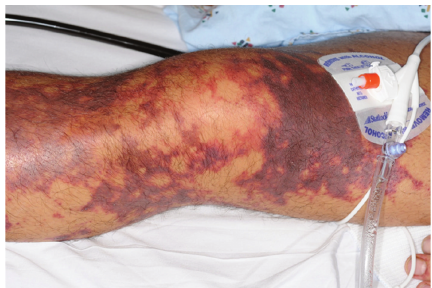
Figure 2: Ecchymotic nonblanching macular lesions on the lower extremity.